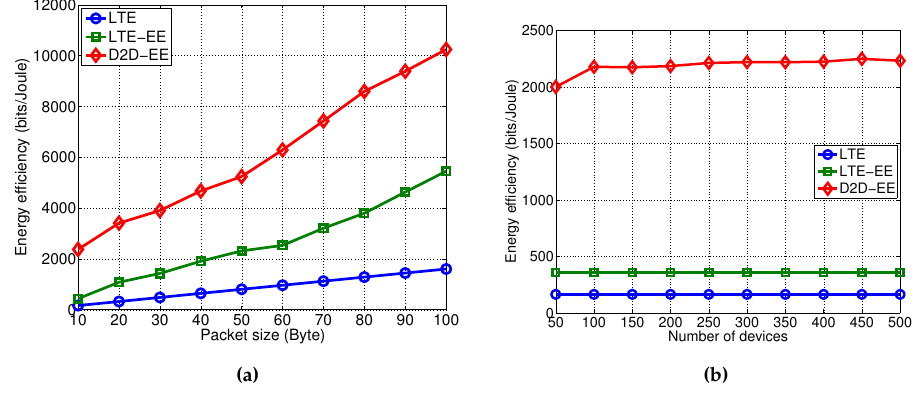
Figure 5. Energy efficiency. ( a ) Varying the packet size (number of devices is 50); ( b ) Varying the number of devices (data size is 10